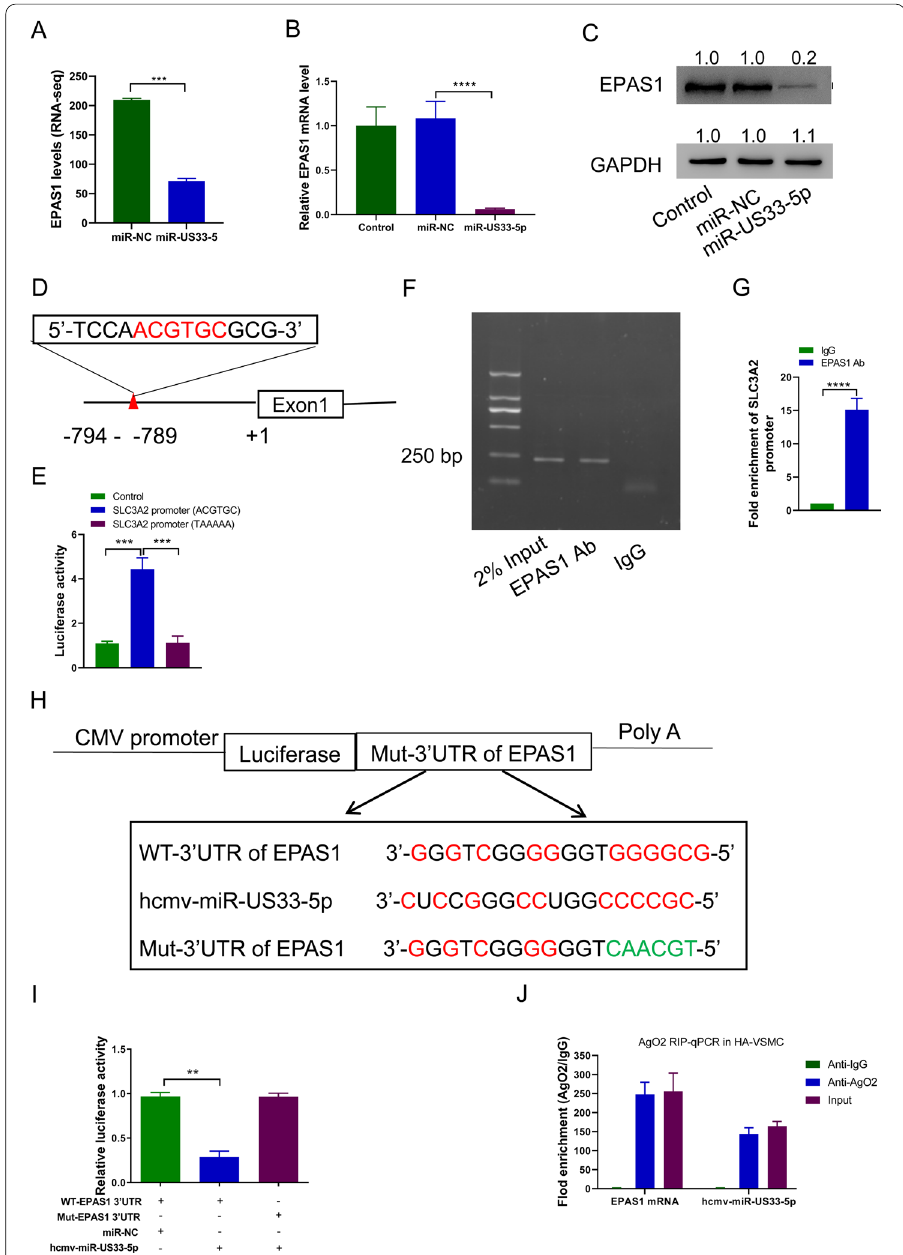
Fig. 5 HCMV-miR-US33-5p downregulates SLC3A2 by targeting EPAS1. A RNA sequencing data showing EPAS1 differential expression between the HCMV-miR-US33-5p and control groups. B , C HCMV-miR-US33-5p was transfected into HA-VSMCs. qRT-PCR ( B ) and Western blot ( C ) were used to analyze the EPAS1 expression level in HA-VSMCs. Western blot was performed three times; representative images are presented. Numbers above lanes represent the relative protein level, normalized relative to control samples. D Potential EPAS1 binding sites in SLC3A2 promoter region. E Luciferase reporter assay of the effect of EPAS1 on the SLC3A2 promoter. F ChIP assay showed that EPAS1 bound to SLC3A2 promoter. G ChIP-qPCR assay of the enrichment of EPAS1 to SLC3A2 promoter. H Potential HCMV-miR-US33-5p binding site in EPAS1 promoter. I Luciferase reporter assay of the effect of HCMV-miR-US33-5p on the EPAS1 promoter. J RIP analysis of the enrichment of Ago2 on 3 ′ -UTR of EPAS1 and HCMV-miR-US33-5p. ** P < 0.01, *** P < 0.001 ( n 3, ANOVA analysis for A and D ; = Student’s t -test for F